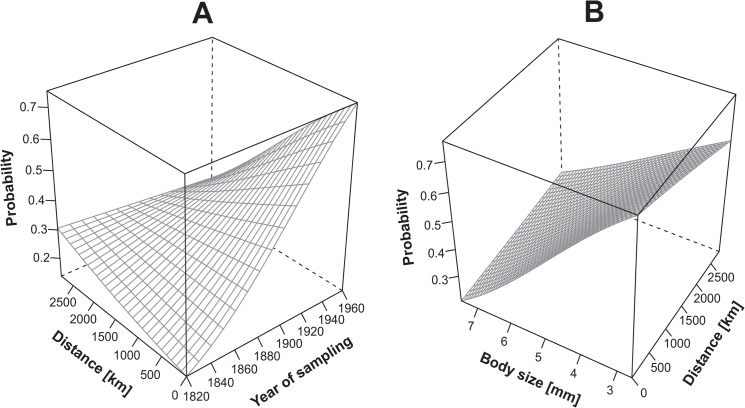
A. Relationship between the probability of genotyping success, distance of the sampling site to the museum collection and year of sampling. B. Relationship between the probability of genotyping success, distance of the sampling site to the museum collection and body size of spiders. Estimated logit models are shown.